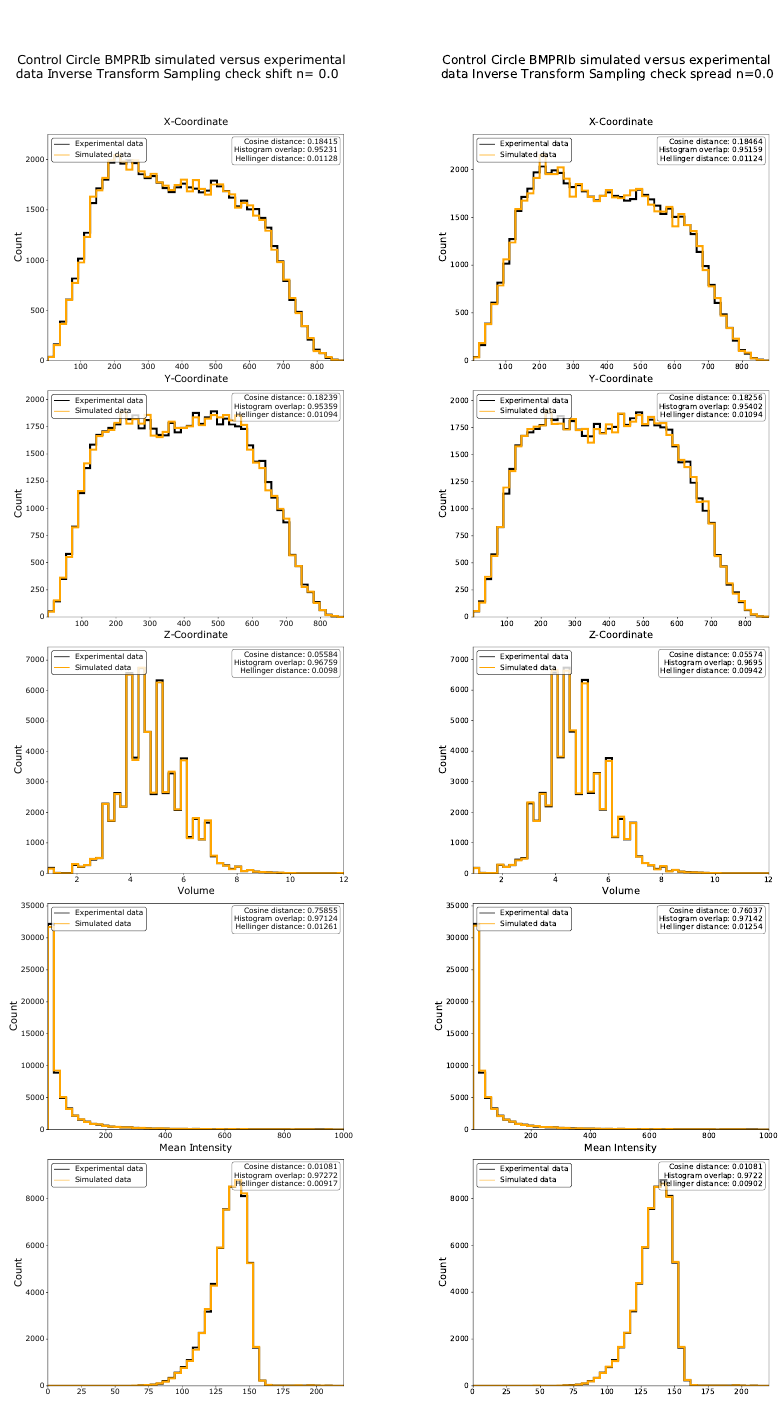
Figure A1. Histograms and similarity metrics of x-, y-, and z-coordinates, as well as mean intensity and volume of Control Circle BMPRIb data with n =